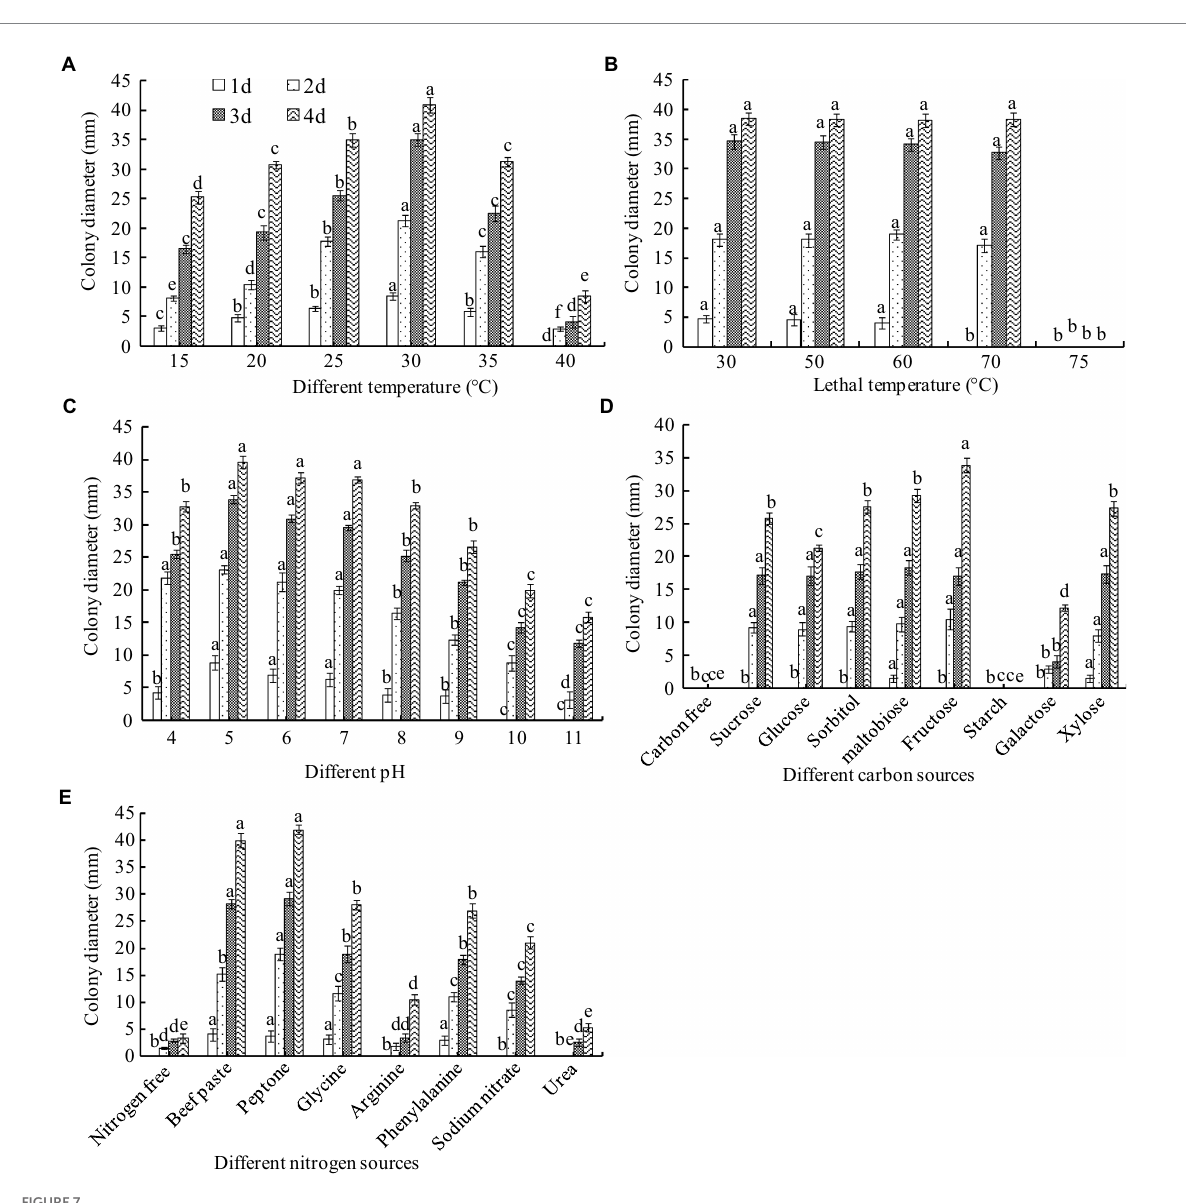
FIGURE 7 Biological characteristics of A. niger . (A) Temperature; (B) lethal temperature; (C) pH; (D) carbon sources; (E) nitrogen sources. ANOVA was employed to compare the mean values of analysis parameters ( p < 0.05). The results are shown as the mean ± standard deviation ( n = 5). Different superscript letters in the same column indicate significant differences ( p <